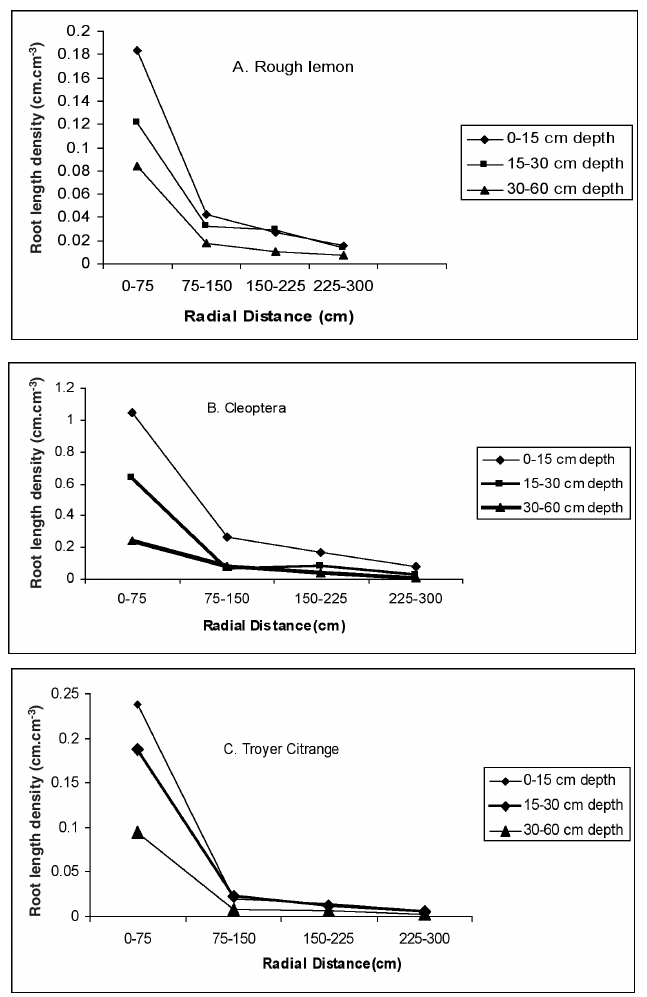
Fig. 2 - Changes in fibrous root length density as a function of soil depth from the surface and radial distance from the tree trunk for pineapple orange trees on (A) Rough lemon (n=5); (B) Cleopatra (n=5) and (C) Troyer citrange (n=5)